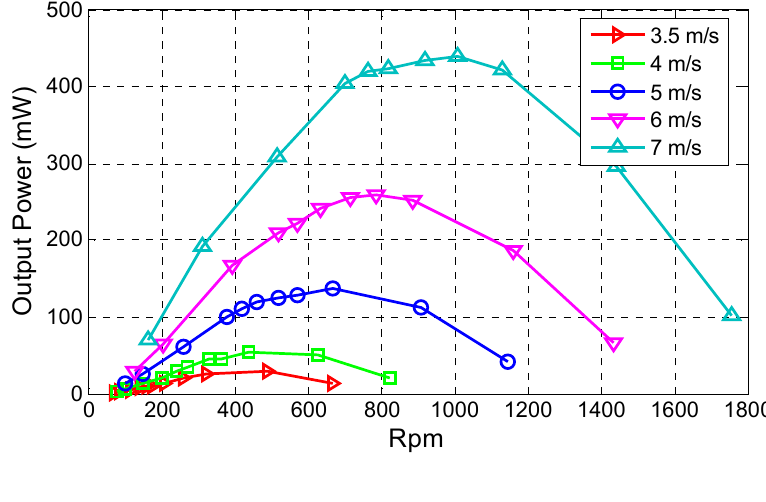
Figure 10. Overall generated power of a micro-wind turbine with a six-blade